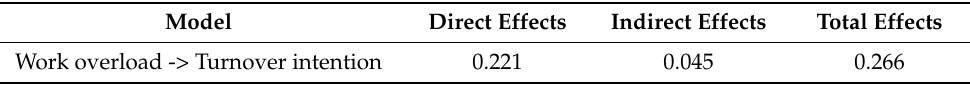
Table 3. Direct, Indirect, and Total Effects of Final Research